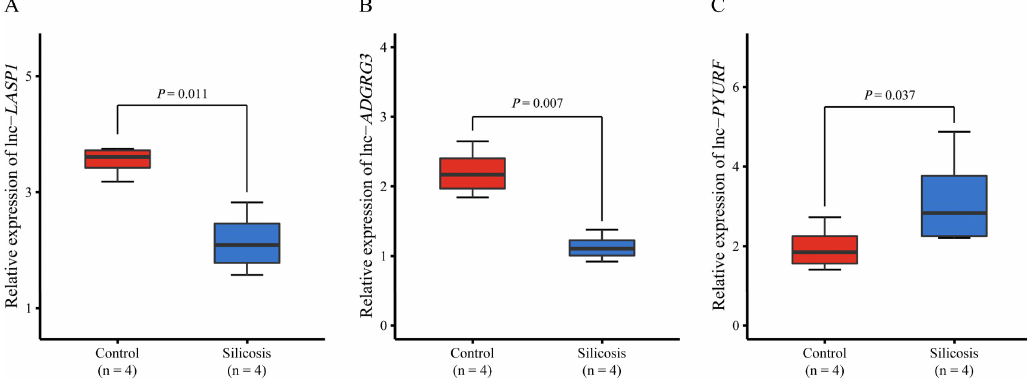
Fig. 3 Di ff erential expression of (A) lnc-LASP1 , (B) lnc-ADGRG3 , and (C) lnc-PYURF between silicosis cases and healthy controls. The P - value was calculated using the limma package in R.